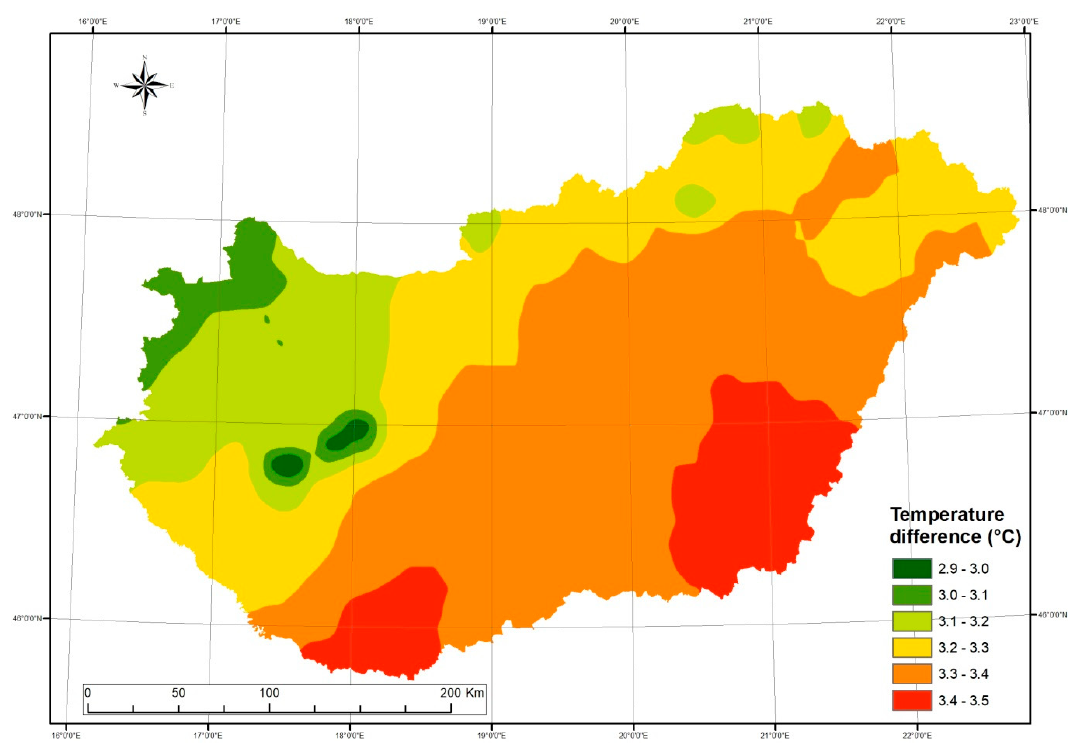
Figure 4. Annual average temperature difference between the 1961–1990 and 2071–2100 periods based on ALADIN simulation results [15].